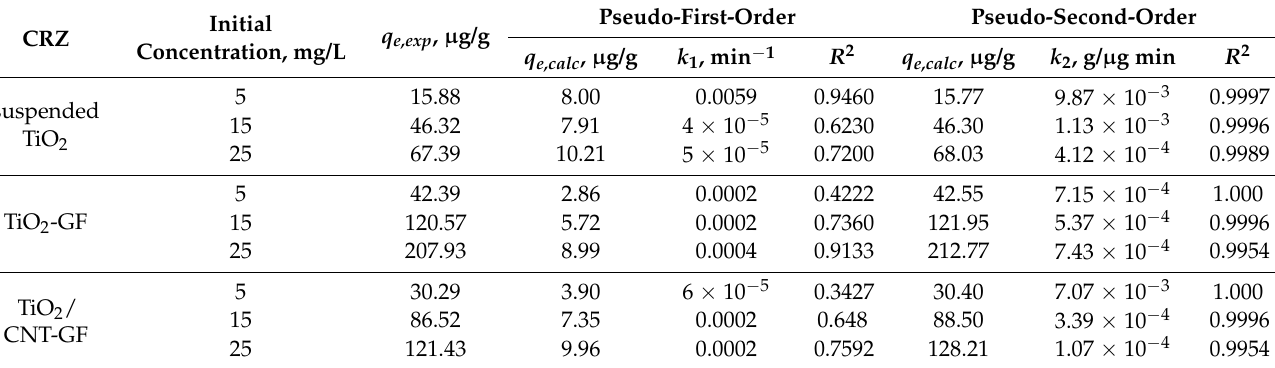
Table 3. Sorption kinetic parameters for CRZ.